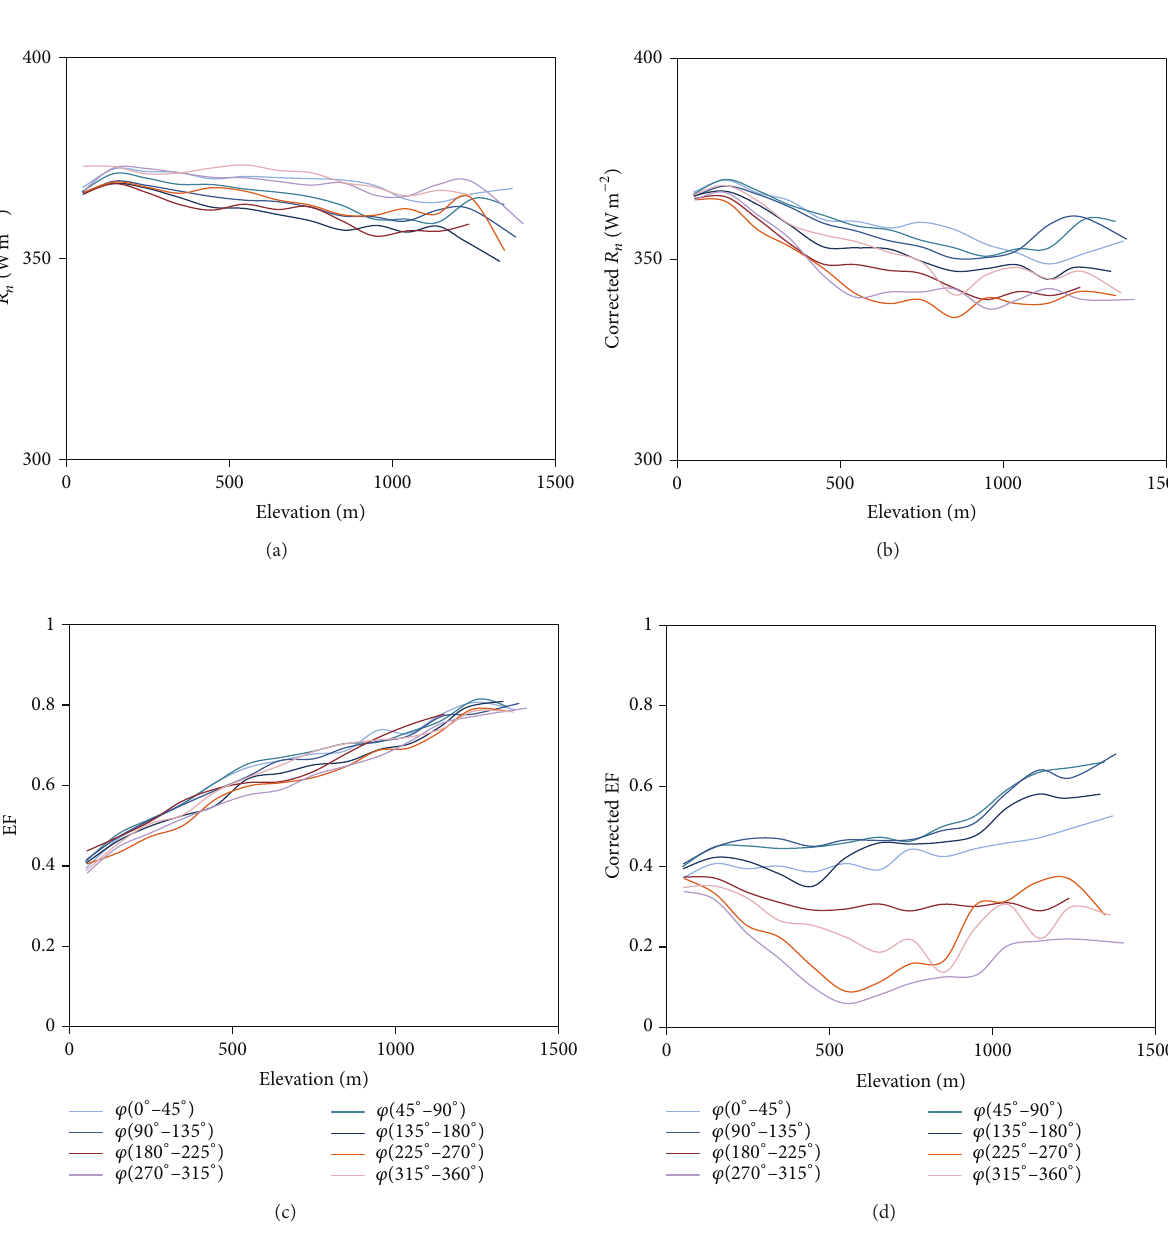
Figure 7: The relationship between 𝑅 𝑛 , EF, and elevation for different terrain aspect angles (𝜑) over the selected Taihu Basin area. (a) The 𝑅 𝑅 𝑛 before the topographic correction, (b) 𝑛 after the topographic correction, (c) EF before the topographic correction, and (d) EF after the topographic